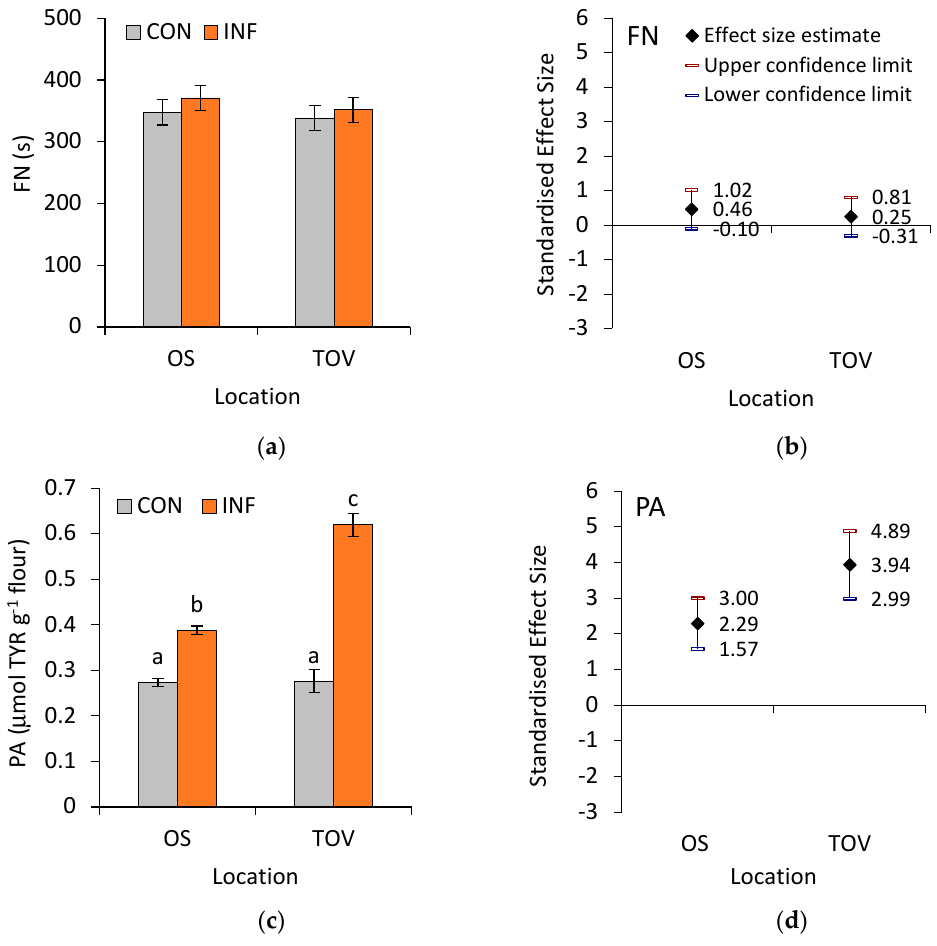
Figure 2. Average values and 95% confidence interval of ( a ) falling number (FN, s) and ( c ) proteolytic activity (PA, μ mol TYR g − 1 flour) in control (uninfected, CON) (n = 25) and infected (INF) (n = 25) flour samples of winter wheat cultivars grown at Osijek (OS) and Tovarnik (TOV) locations. An estimate of standardized effect size with a 95% confidence interval of Fusarium infection on FN ( b ) and PA ( d ) of winter wheat cultivars grown at Osijek (OS) and Tovarnik (TOV). For all variables with the same letter, the difference in means is not statistically significant (at p < 0.05, Tukey HSD).